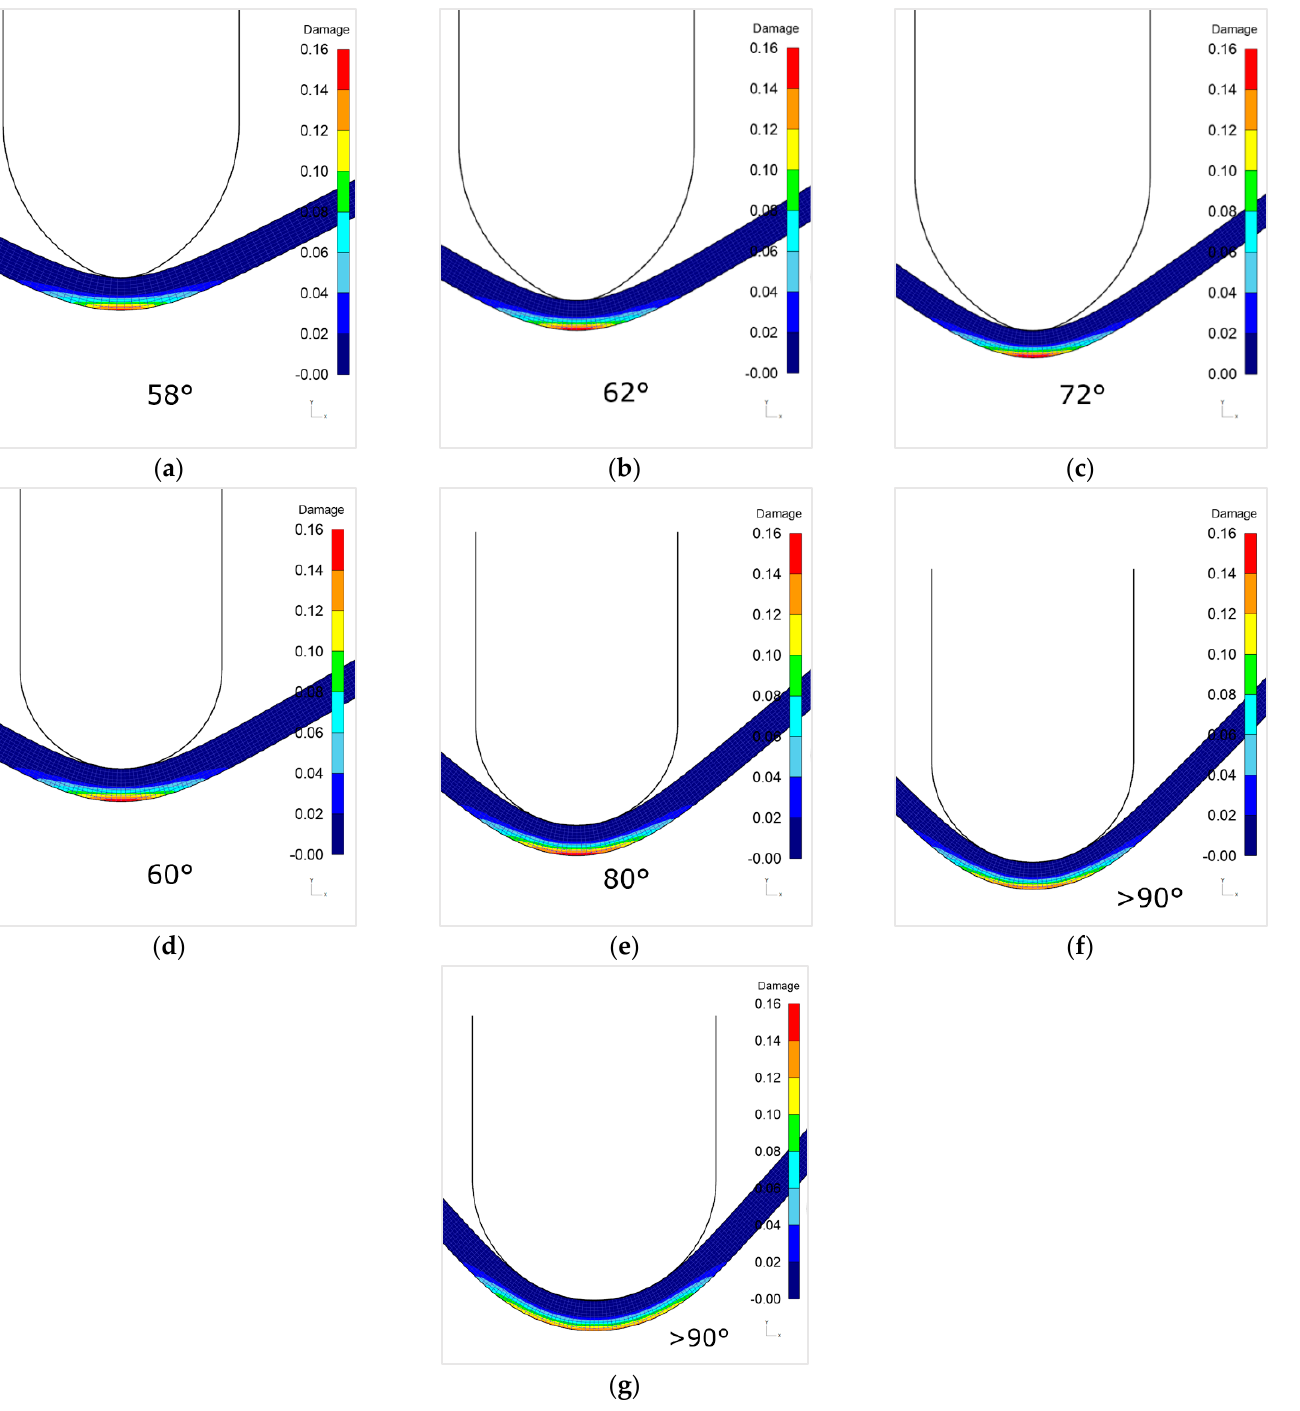
Figure 6. FEM simulated D.O.B. in the moment before fracture initiation: ( a ) 5 mm, R10; ( b ) 4.5 mm, R10; ( c ) 4 mm, R10; ( d ) 5 mm, R15; ( e ) 45 mm, R15; ( f ) 4 mm, R15; ( g ) 5 mm, R20.